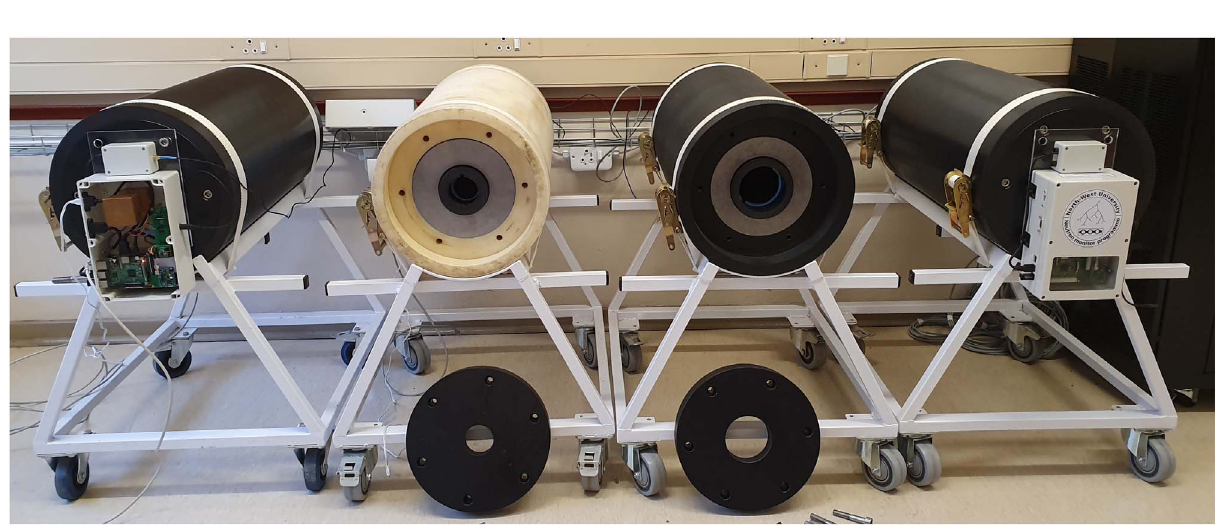
Fig. 2. Mini-NMs undergoing testing. The front covers were removed on two monitors to show the lead rings and the internal moderators.